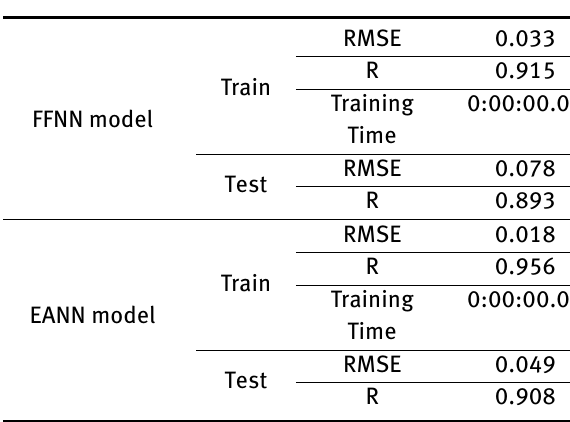
Table 2: The results of FFNN and EANN models